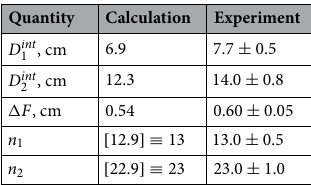
Table 1. Sizes of spectra and interference